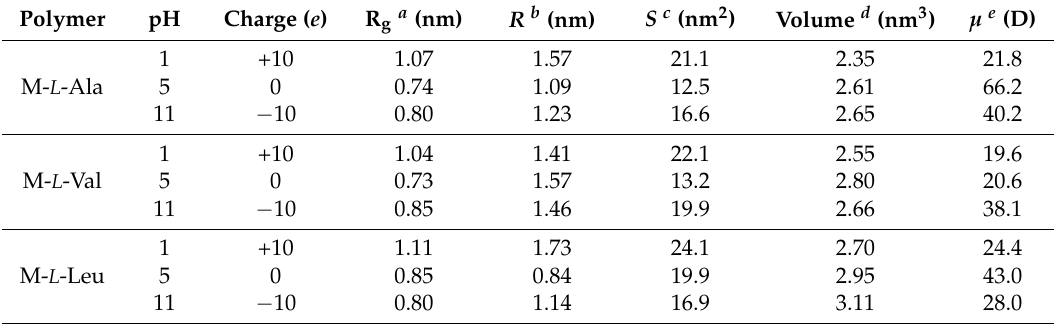
Table 2. Properties of the simulated PAACs at different pH values in water at the end of the MD runs and final geometry optimization.